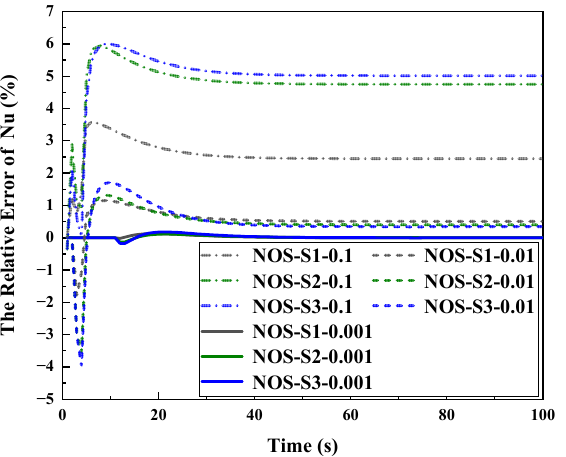
Figure 8. The relative error of the average Nu of the three rectangular block surfaces of the novel optimization strategy with different criteria relative to the traditional coupling algorithm.